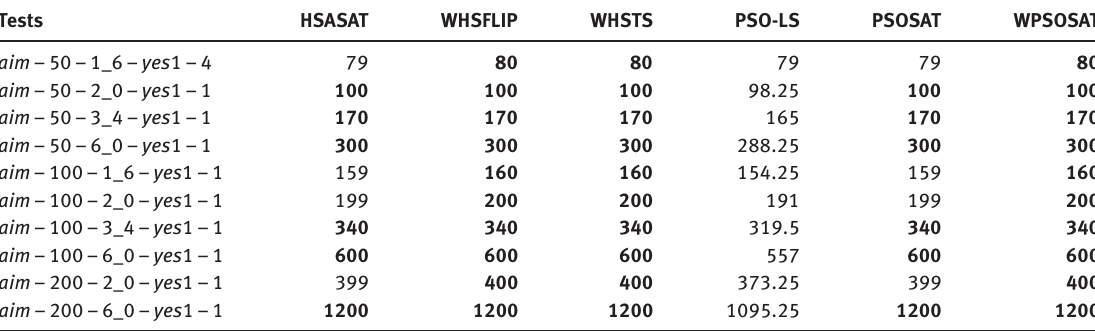
Table 2: Comparative Results